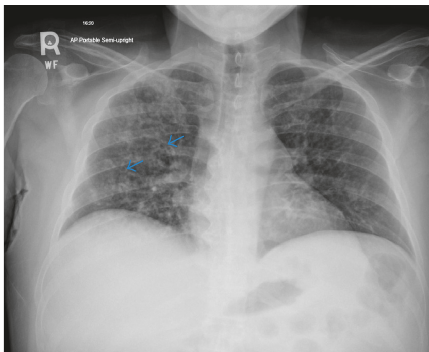
Figure 1: Chest roentgenogram at referring hospital. AP chest radiograph at outside hospital performed 4 days prior. Diffuse micronodules greater in the right lung are seen. Hint of small cavities is noted (blue arrows).